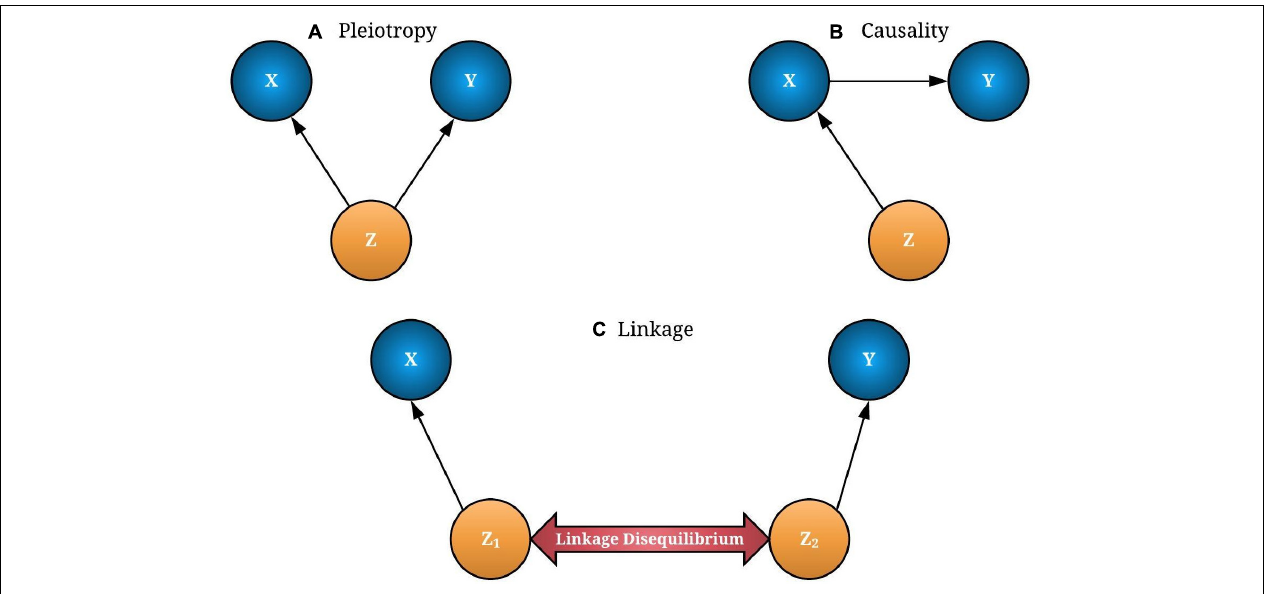
FIGURE 1 | The possible associations between gene expression (X) and trait/disease (Y) through a causal variant single-nucleotide polymorphism (SNP-Z). If both X and Y are affected by SNP (Z), it is called “pleiotropy” (A) . If Y is affected by Z through X, it is known as causality (B) . In linkage models, two distinct causal variants (Z 1 and Z 2 ) can be in a linkage disequilibrium (LD) that causes X and Y independently (C) . Pleiotropy and causality of interest should be extracted from linkage models for a better transcriptome-wide association studies (TWAS) interpretation. The concept for the image was adapted from Zhu et al.